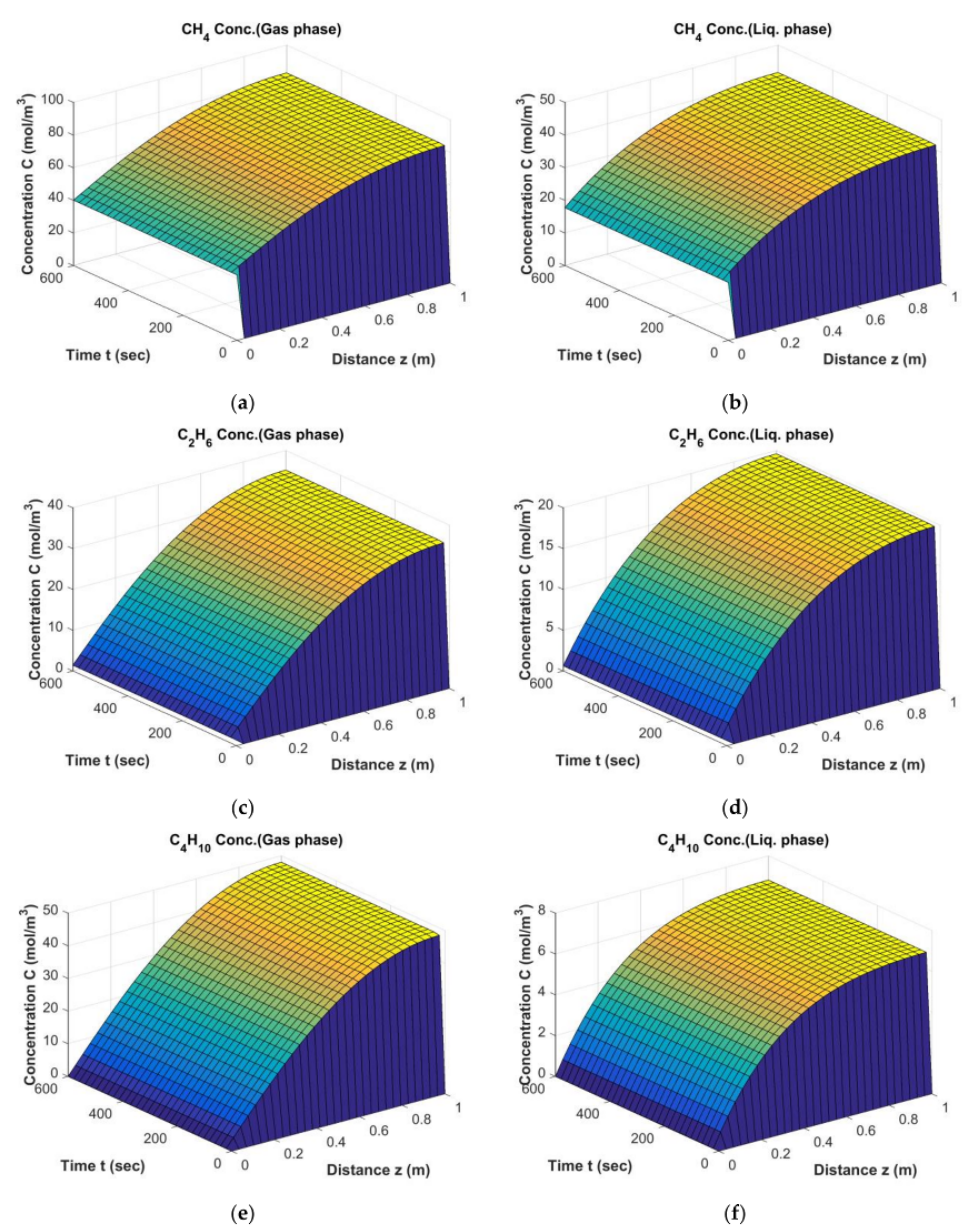
Figure 3. Results of FT Simulation; The behavior of CH 4 , C 2 H 6 and C 4 H 10 in gas phase ( a , c , e ) and liquid phase ( b , d , f ) from start-up to steady state conditions (D t = 0.1 m, H = 2.5 m, ε cat = 0.34, U g,in = 0.17